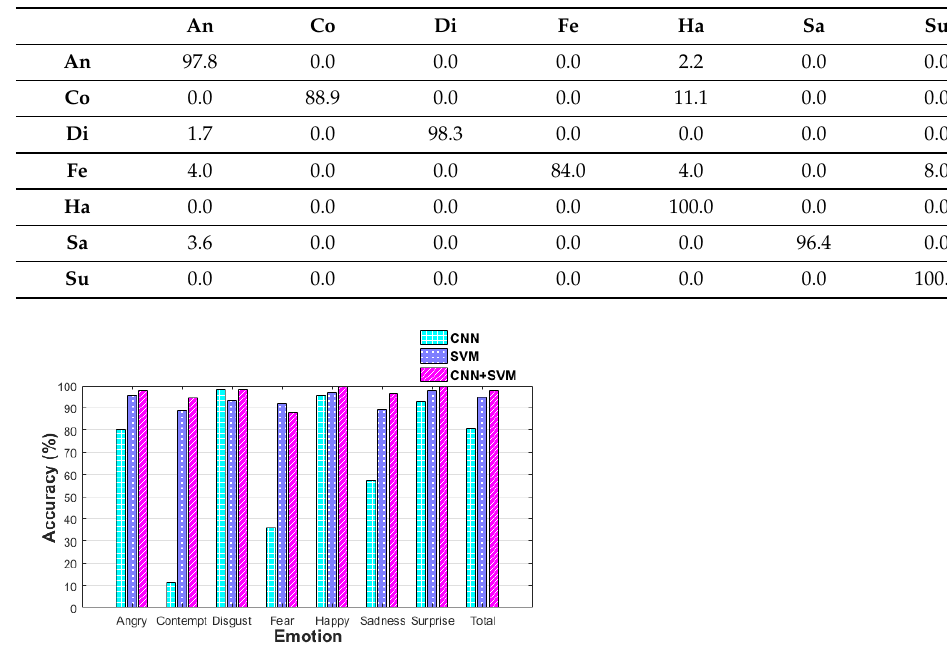
Figure 8. Comparison of facial expression classification